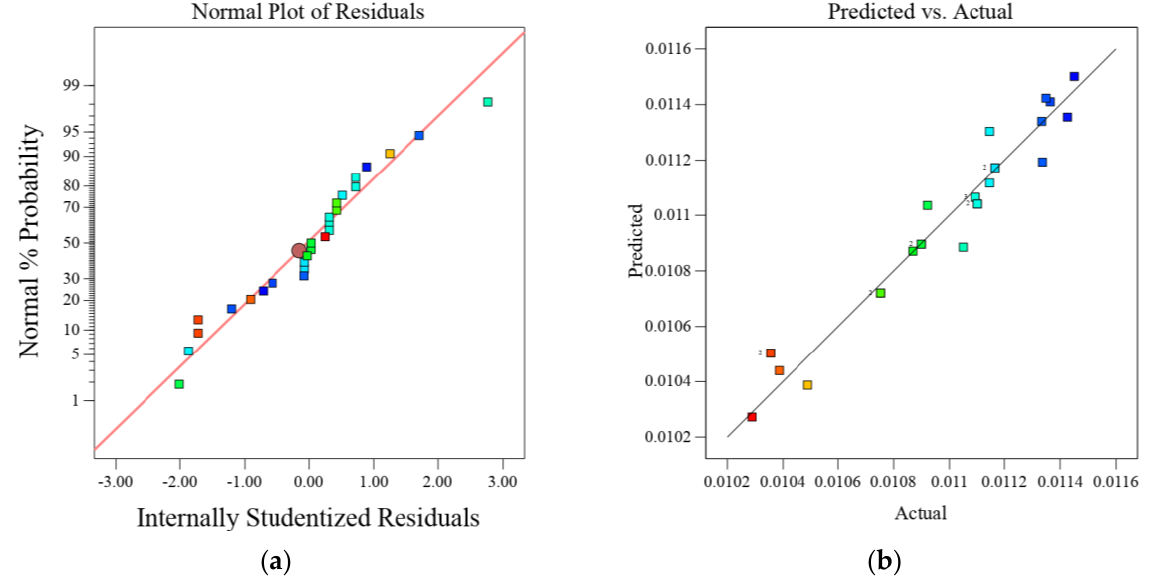
Figure 4. Residual plots: ( a ) normal probability, ( b ) predicted versus actual for removal of lead by Odaracha.